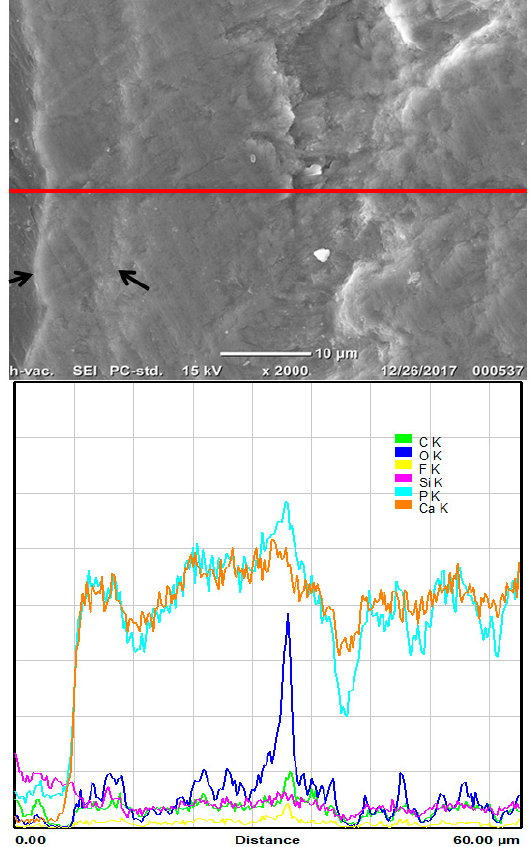
Figure 7. Examination of the Biomin group (D) with high magnification. Pointers are pointing to the newly formed layer on the demineralized enamel with strong calcium and phosphate peaks.